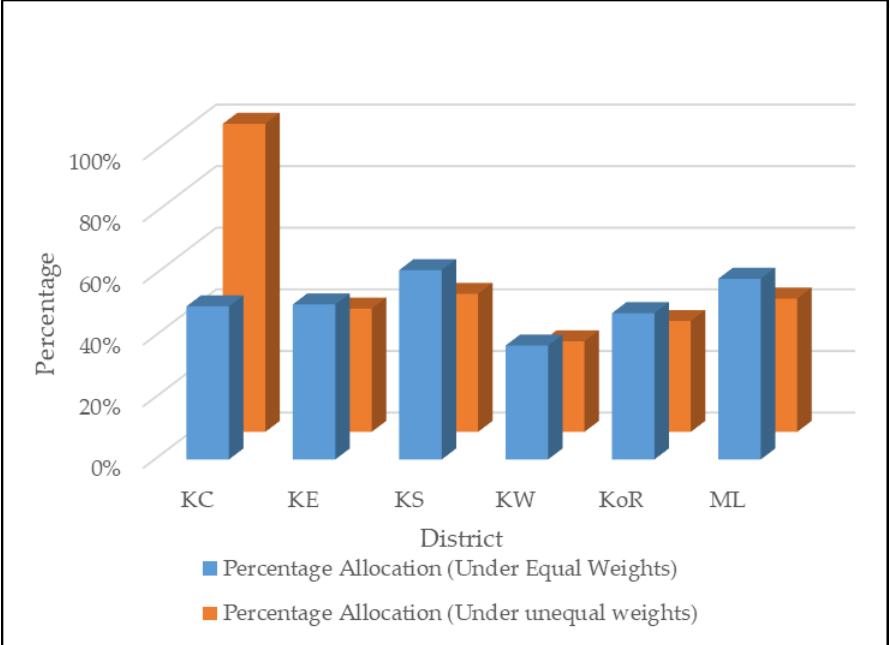
Figure 4. Water allocation under homogenous and heterogenous weights (scenario 4).